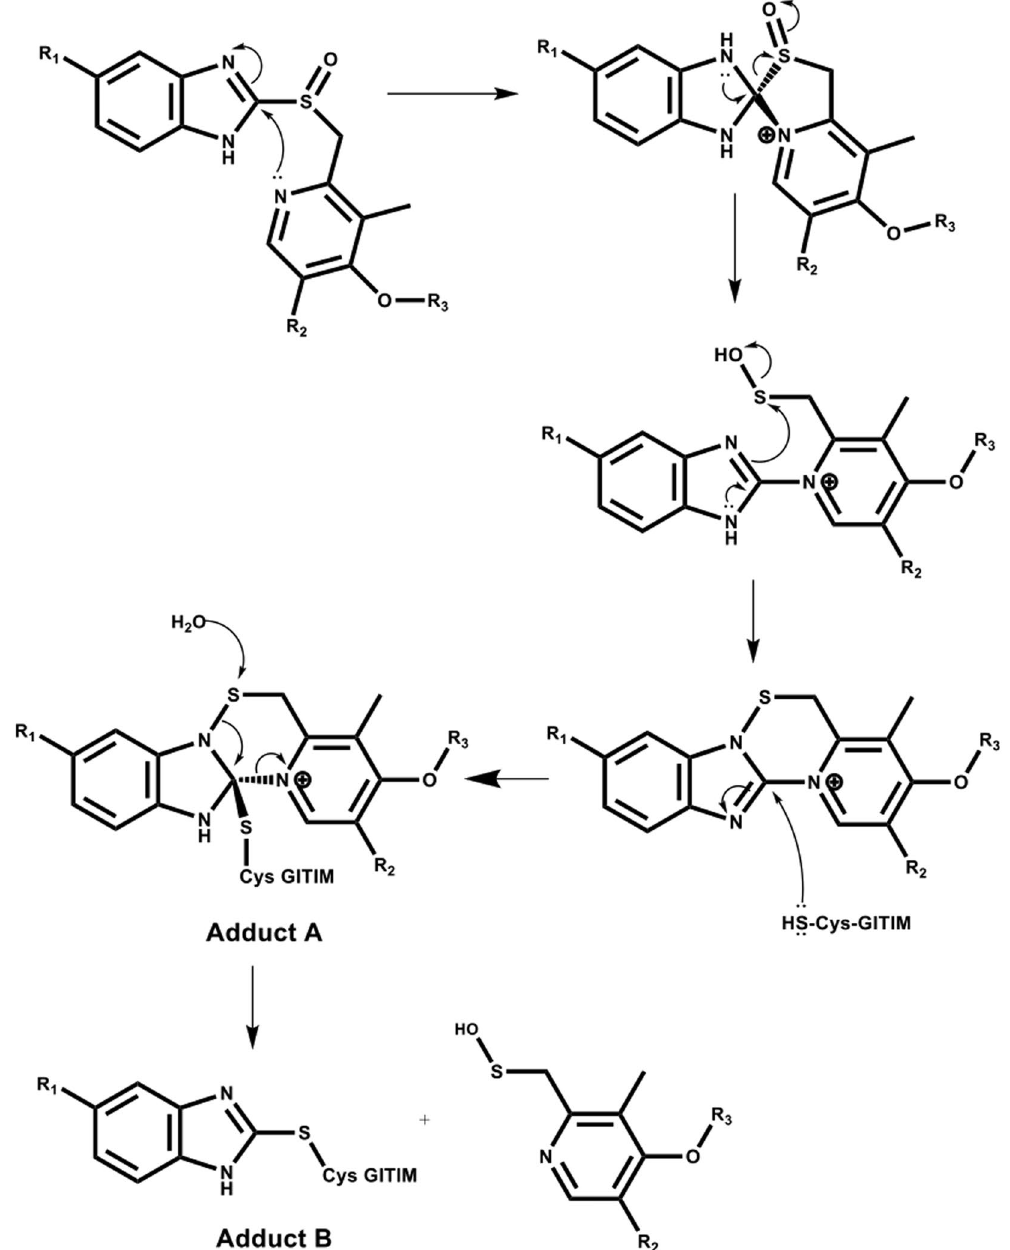
Figure 7. Proposed mechanism of formation of adducts ( A ) and ( B ). Mechanism of reaction of compounds and neutral